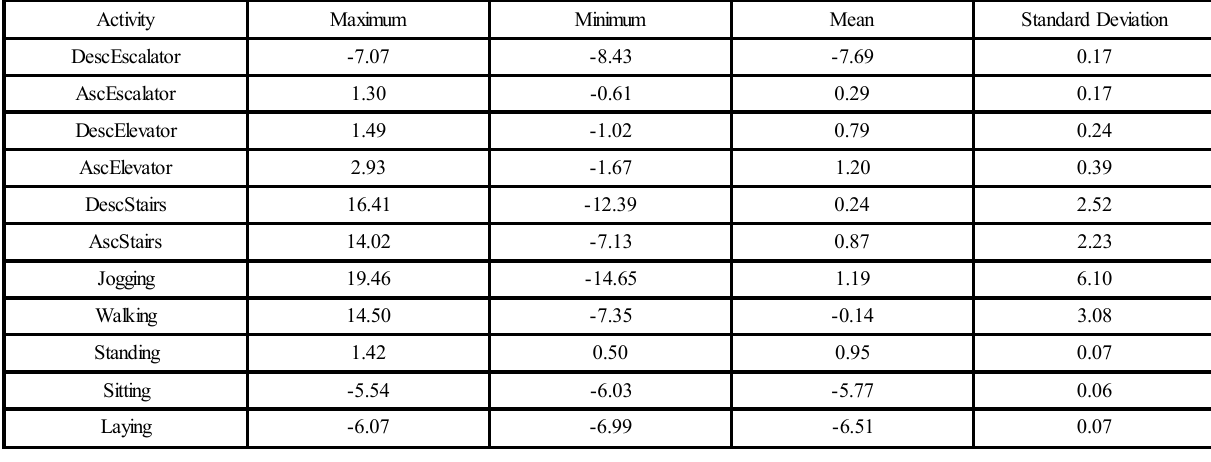
TABLE 1. STATISTICAL DATA FEATURES OF 11